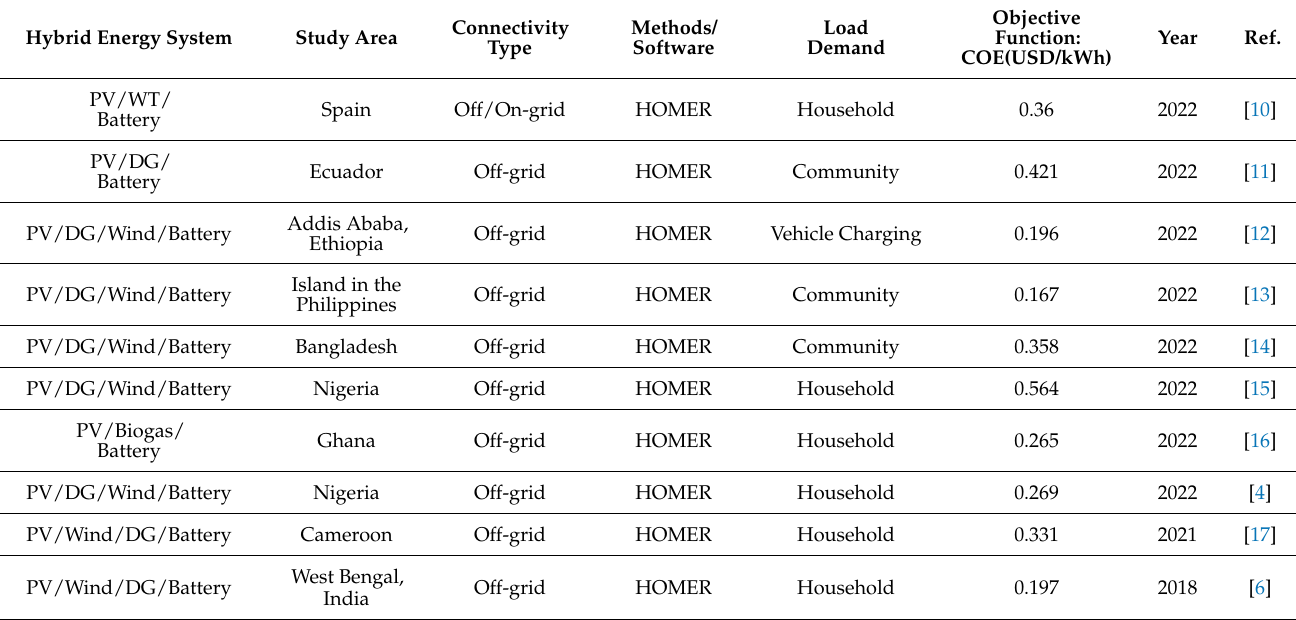
Table 1. Summary of hybrid energy system using different